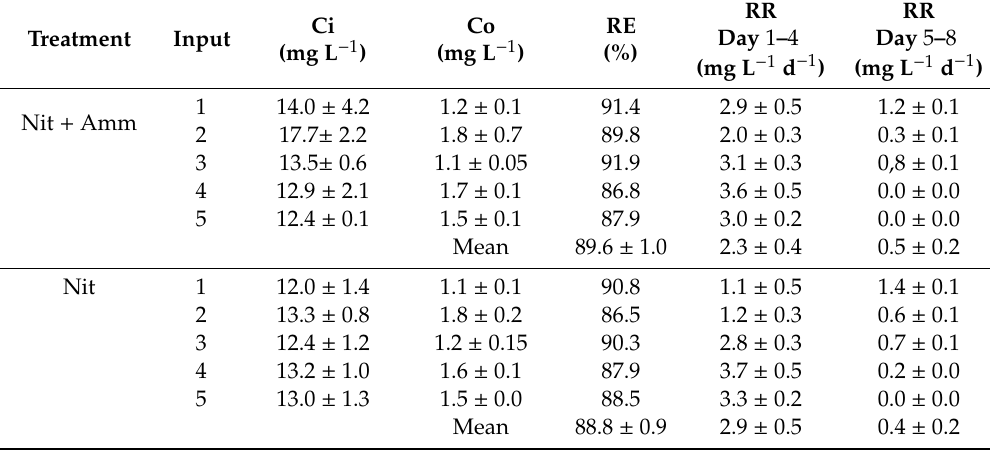
Table 2. Nitrate-nitrogen (NO 3 − N) concentration in the influent water at day 1 (Ci) and in the e ffl uent at day 8 (Co), removal e ffi ciency (RE) and removal rate (RR) for each treatment irrigated with nitrate-N and ammonium-N (Nit + Amm) and nitrate-N (Nit). Each input corresponds to a new irrigation with nitrate-N and ammonium-N (Nit + Amm) or nitrate-N (Nit). Each input has three lysimeters per treatment. Treatments were irrigated with nitrate-N and ammonium-N (Nit + Amm) and nitrate-N (Nit). Mean values of three lysimeters per treatment are displayed ( ± SE). Ci Treatment Input (mg L − 1